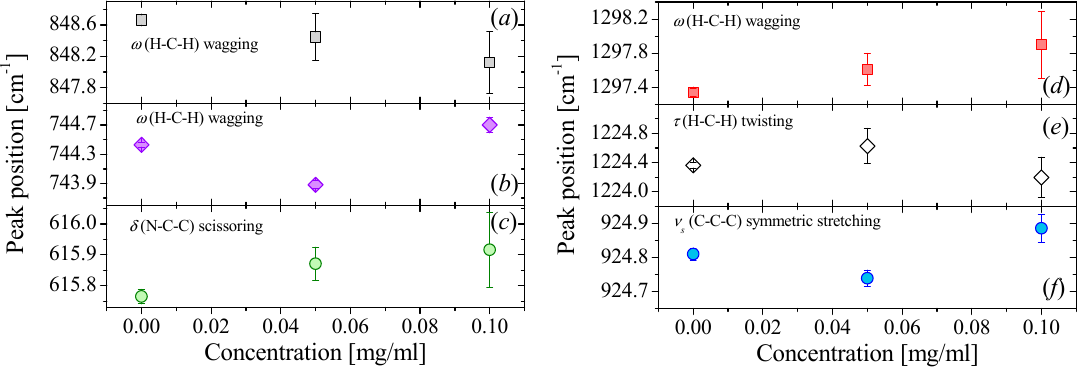
Figure 4. ( a )–( f ) Peak positions of six Raman bands of NMP shown in Figure 3 as a function of graphene concentration.